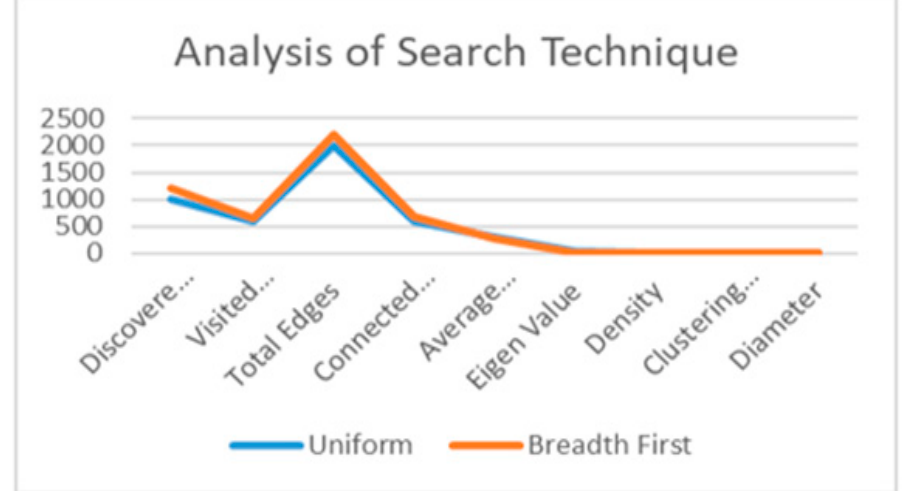
Figure 6. Comparison of uniform search and breadth-first search Figure-6. Comparison of uniform search and breadth-first search techniques .